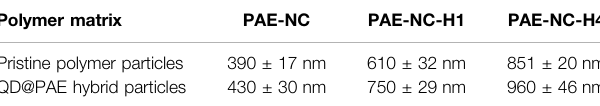
TABLE 1 | The average diameters of pristine and QD@PAE hybrid microparticles. Polymer